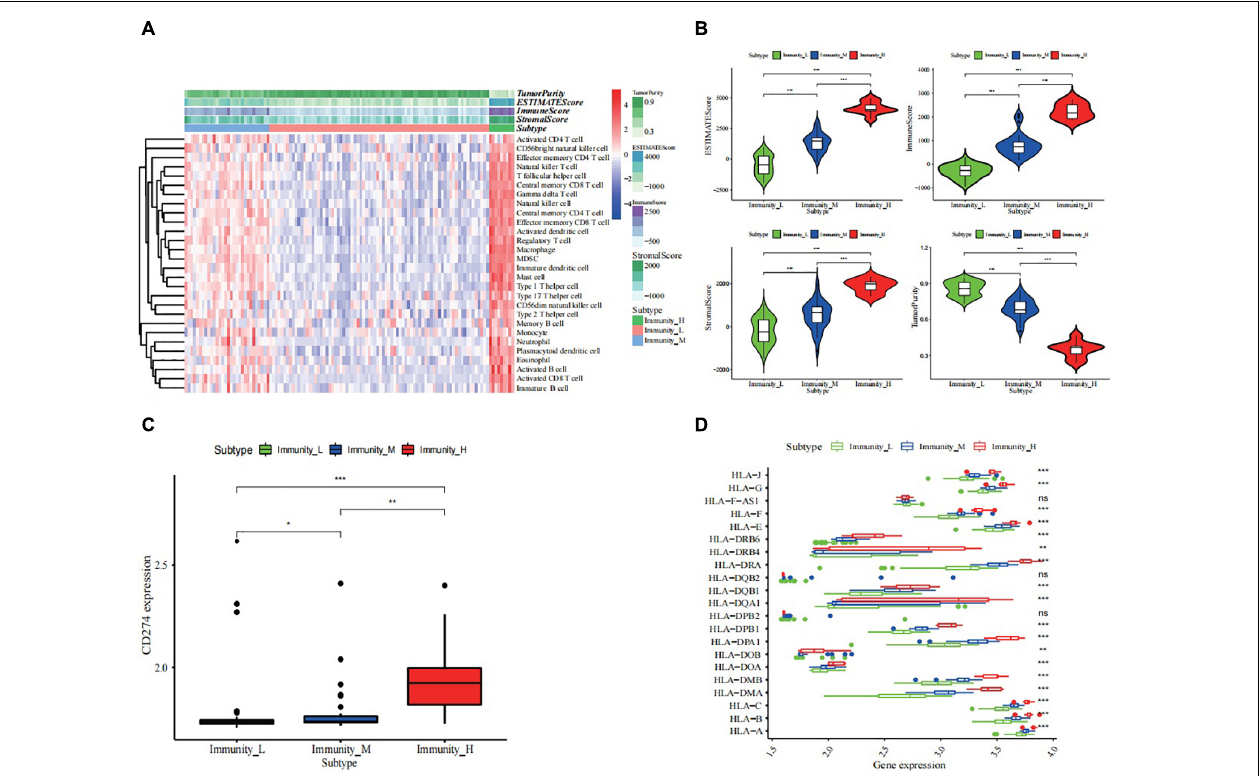
FIGURE 2 | Construction and validation of ES clustering. (A) The enrichment levels of 28 immune-related cells in the high immune cell infiltration group (Immunity_H), middle immune cell infiltration group (Immunity_M), and the low immune cell infiltration group (Immunity_L). The Tumor Purity, ESTIMATE Score, Immune Score and Stromal Score of every patient gene were showed combine with the clustering information. (B) The violin plot showed the difference in ESTIMATE Score, Immune Score, Stromal Score, and Tumor Purity between three clusters. The statistical method is wilcoxon test (C,D) The kruskal-wallis test showed the expression of most HLAs and the wilcoxon test showed PD-L1 (CD274) was a significant difference in high- (red), middle- (blue), and low- (green) immune cell infiltration cluster. na adj. p > 0.05, * adj. p < 0.05, ** adj. p < 0.01, *** adj. p < 0.001. ns, no statistically significant., p -value correction for multiple testing.